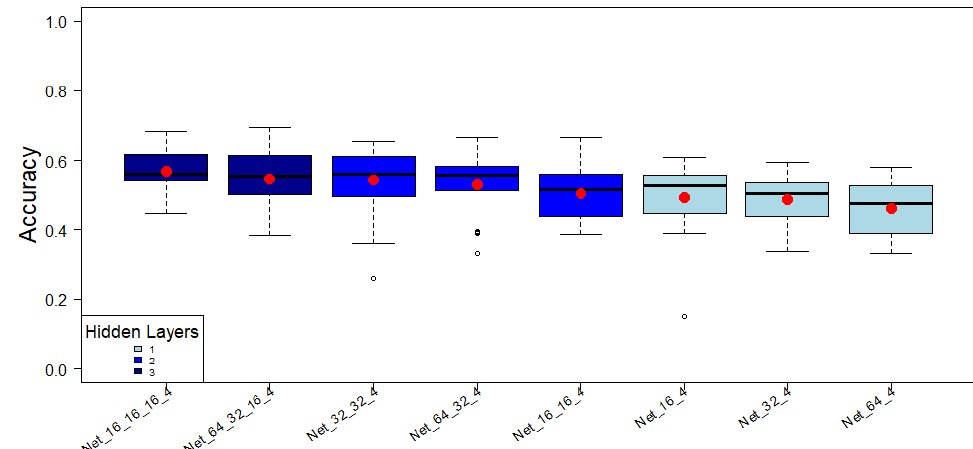
Figure 4. Statistical distributions of the variable Accuracy for every ANN Model ordered by mean value (red circle) represented though box and whisker plots. The colors group the models by their quantity of hidden